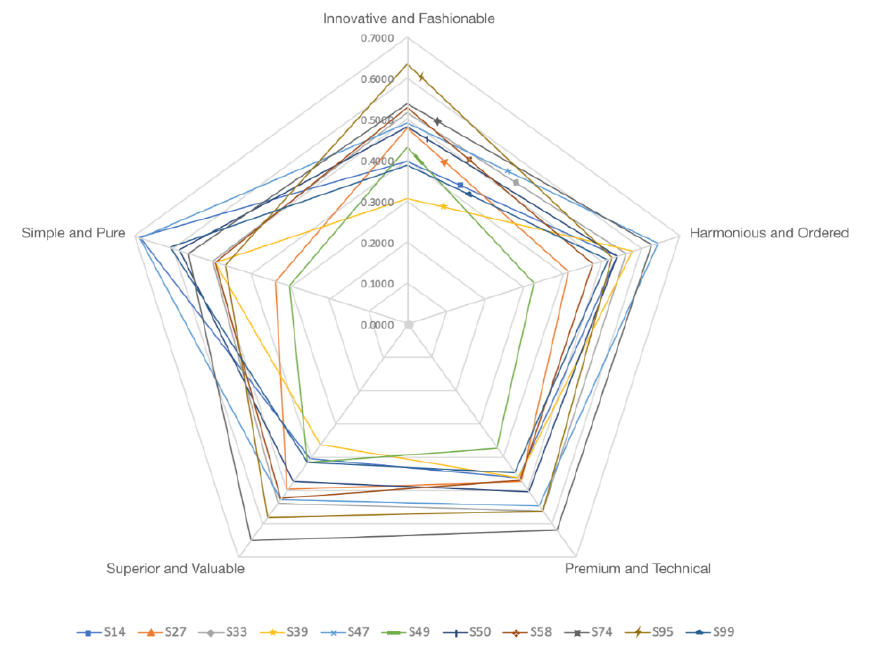
Figure 8. The radar map for visual image